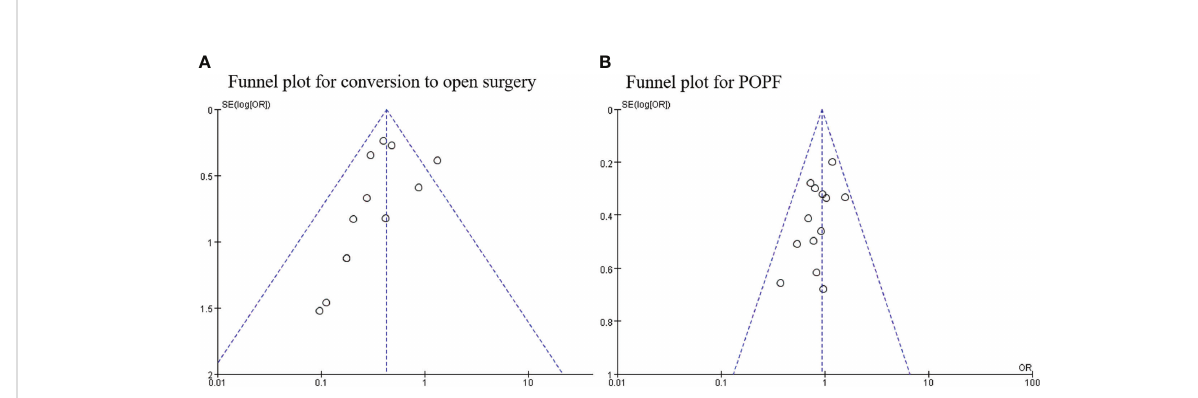
FIGURE 9 (A) Funnel plot for conversion to open surgery and (B) postoperative pancreatic fi stula.